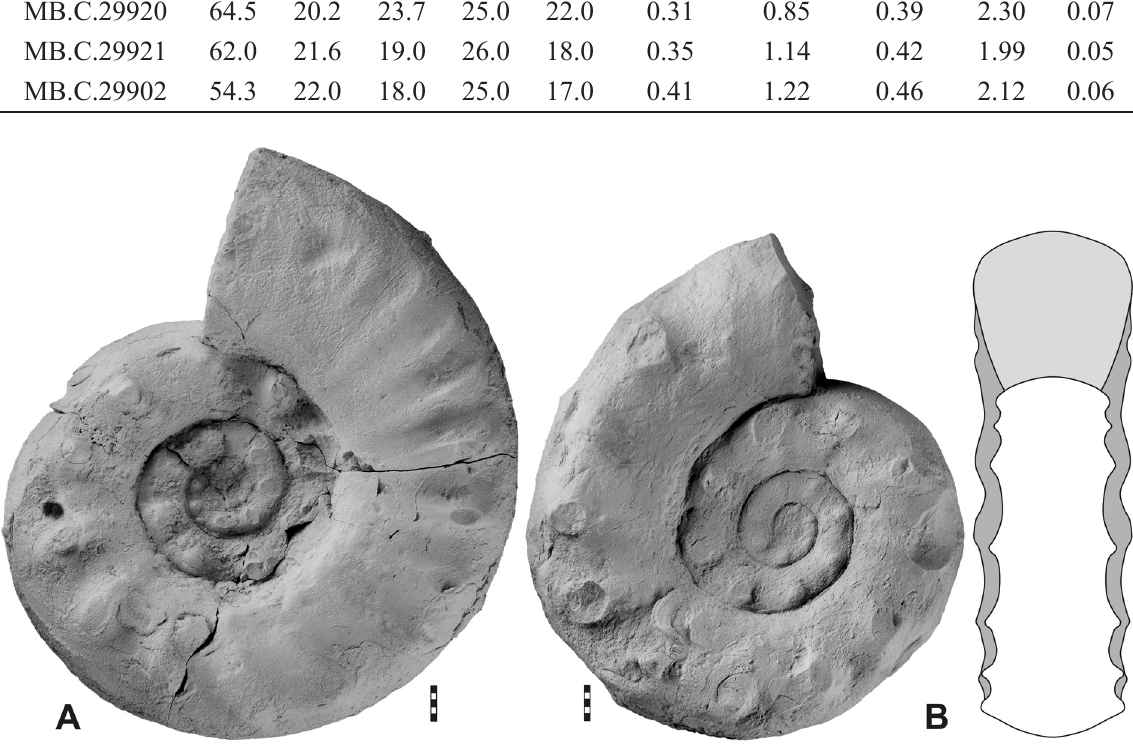
Fig. 37. Paratirolites aduncus Korn & Hairapetian sp. nov. A . Paratype MB.C.29922, section G, float. B . Paratype MB.C.29884, section 1, float. Scale bar units = 1